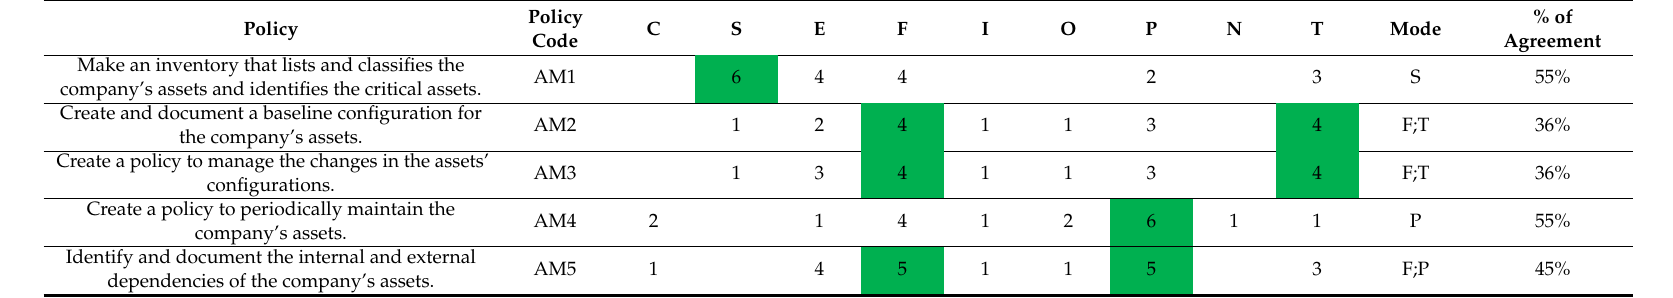
Table 9. Asset management policies’ progression type.